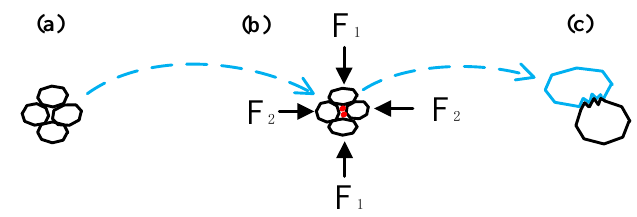
Figure 13. Schematic diagram of the molding process during briquetting. ( a ) Loosely packed particles, ( b ) particles formed under loading and ( c ) the interpenetration of particles.